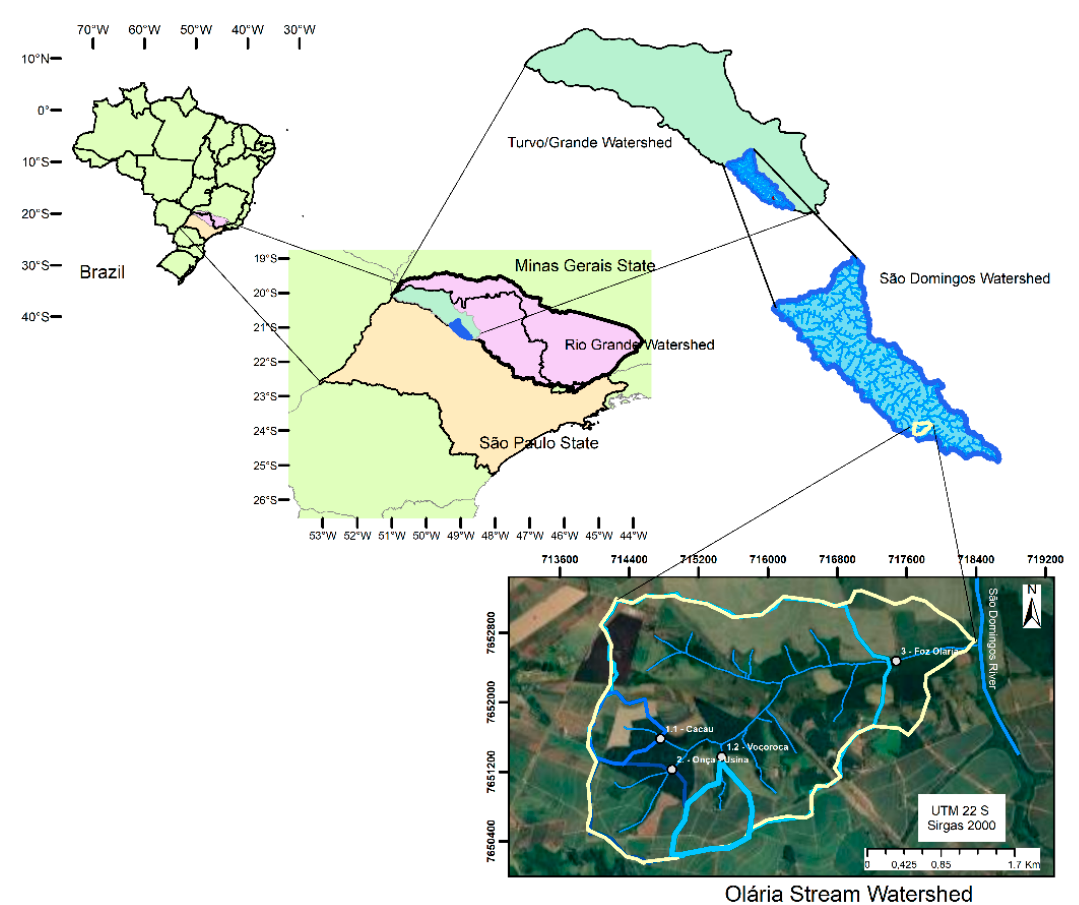
Figure 1. Olaria Stream Watershed, São Domingos River watershed, Turvo/Grande watershed, UGRHI-15, São Paulo State, Brazil.